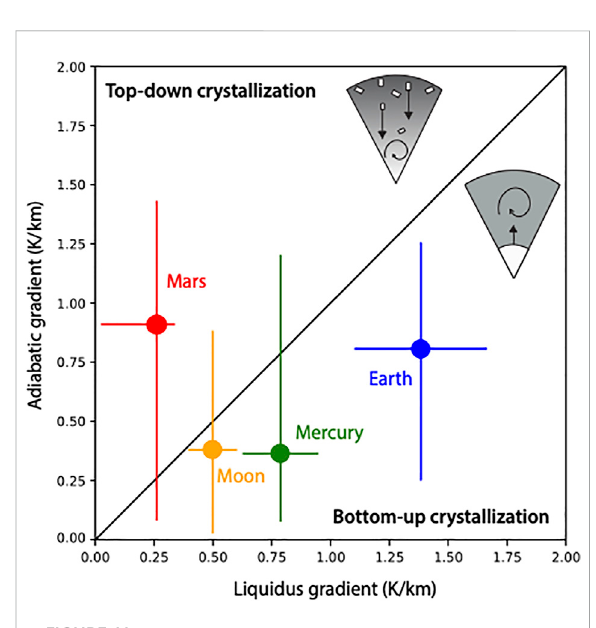
FIGURE 11 Comparison of the core solidi fi cation regimes of Mercury, Mars, the Moon, and Earth. Cores with adiabatic gradients steeper thanthecoreliquidussolidifyatthetopofthecoreina “ top-down ” style, potentially generating “ iron snow ” . Cores with liquidus gradientssteeperthantheadiabatsolidifyatthebaseofthecorein a “ bottom-up ” style. The adiabatic gradient is dT/dr ad = α gT CMB /c p . Vertical error bars re fl ect the range of plausible values, horizonal error bars are assumed to be 20% of the nominal value. The two greyscale sketches represent cross-section of the core in each regime,withsolidsinwhiteandliquidingrey.Theparametersused in this fi gure are listed in Table